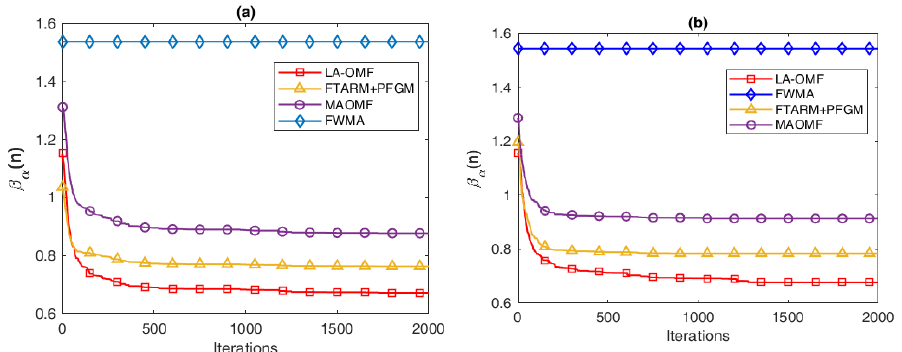
Figure 13. Change of along with different numbers of iterations for four test algorithms on different datasets. (a) 50k sessions and (b) 250k